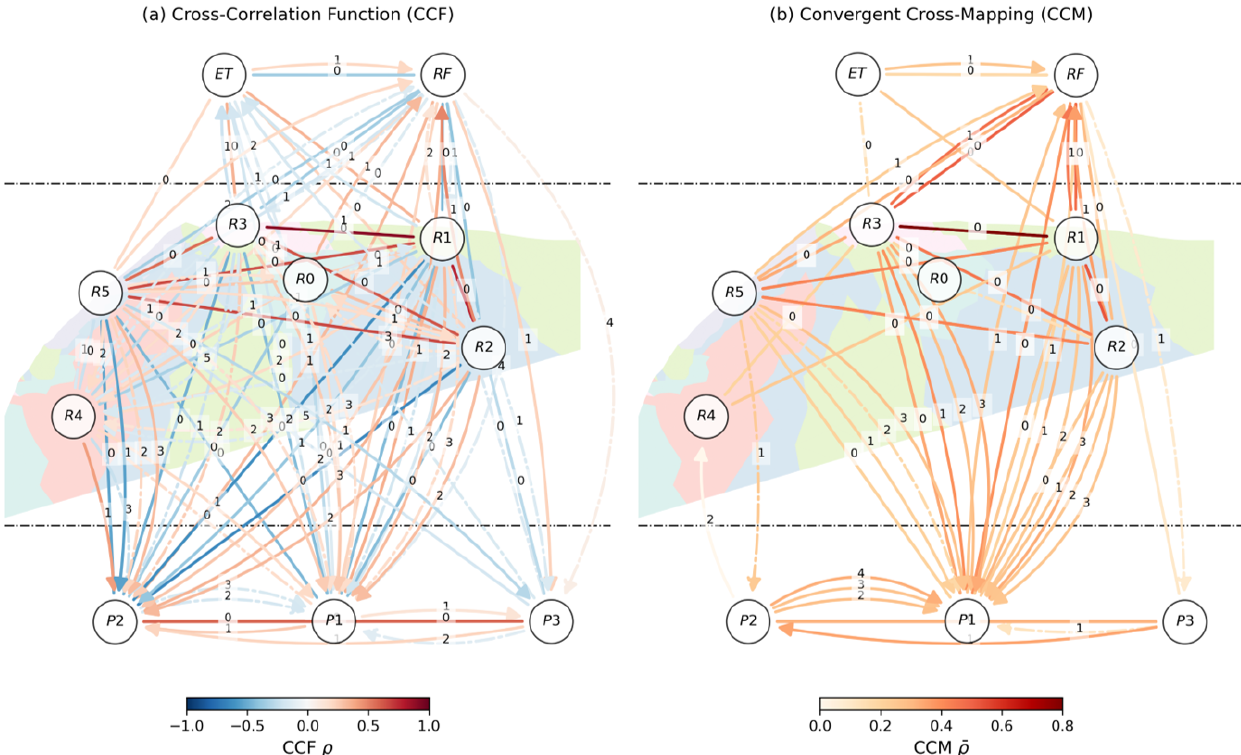
Figure 4. Graph of pairwise cross-dependencies: (a) with the linear cross-correlation function (CCF) and (b) with the nonlinear convergent cross-mapping (CCM) method. An undirected line represents contemporaneous dependencies. Delayed dependencies are shown using di- rected curved arrows. All corresponding delays d are displayed in the middle of its corresponding arrow. The colors of the arrows map to the strengths of dependencies. Solid and dash-dotted arrows represent, respectively, significant dependencies with p value < 0 . 001 and < 0 .